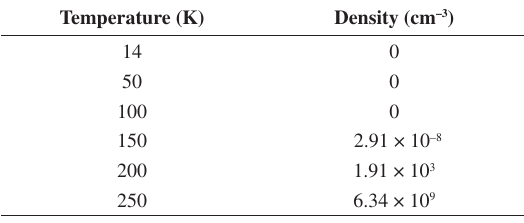
Table 3. Temperature dependence of carrier density.